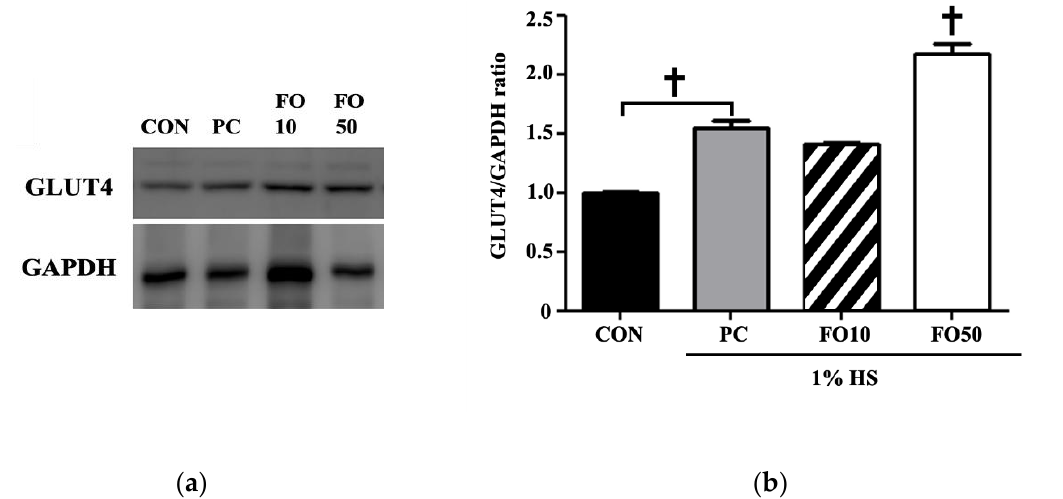
Figure 5. Changes in ( a ) glycogen and ( b ) Adenosine triphosphate (ATP) levels were determined in C2C12 muscle cells following administration of 10 and 50 μg/mL of FO. Each bar represents the mean ± SD. A one-way ANOVA test was used to determine significant differences (* p < 0.05 vs. positive control, † p < 0.001 vs. positive control).